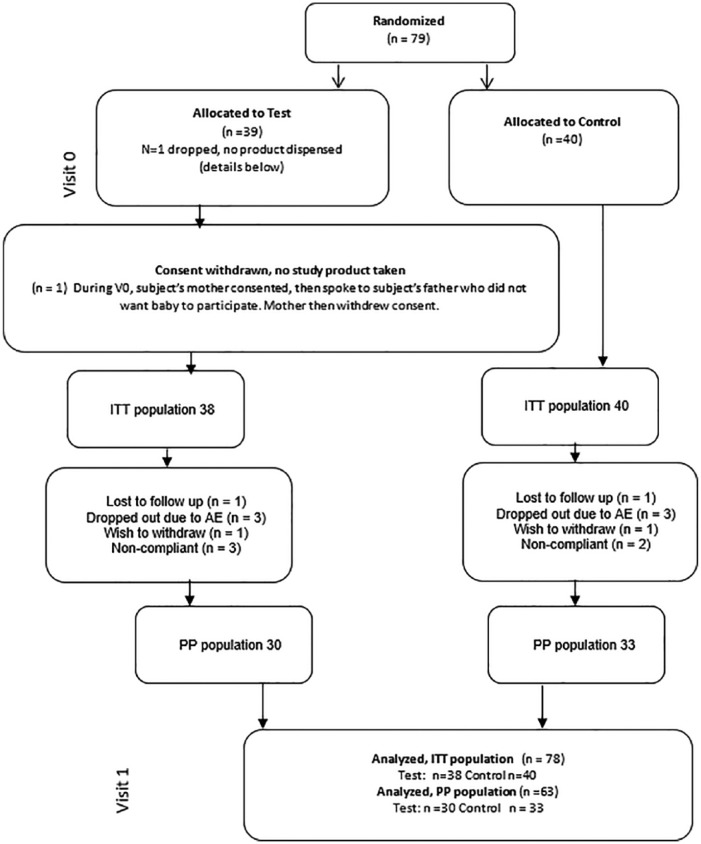
Flow diagram of subject randomization, allocation, and analytic populations.